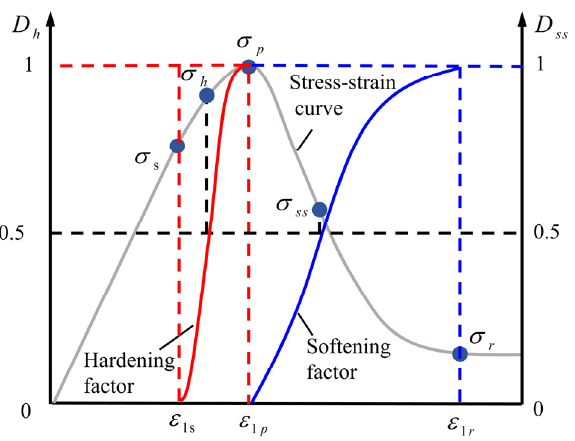
Figure 2. Evolution schematic of normalised strain hardening and softening factors.